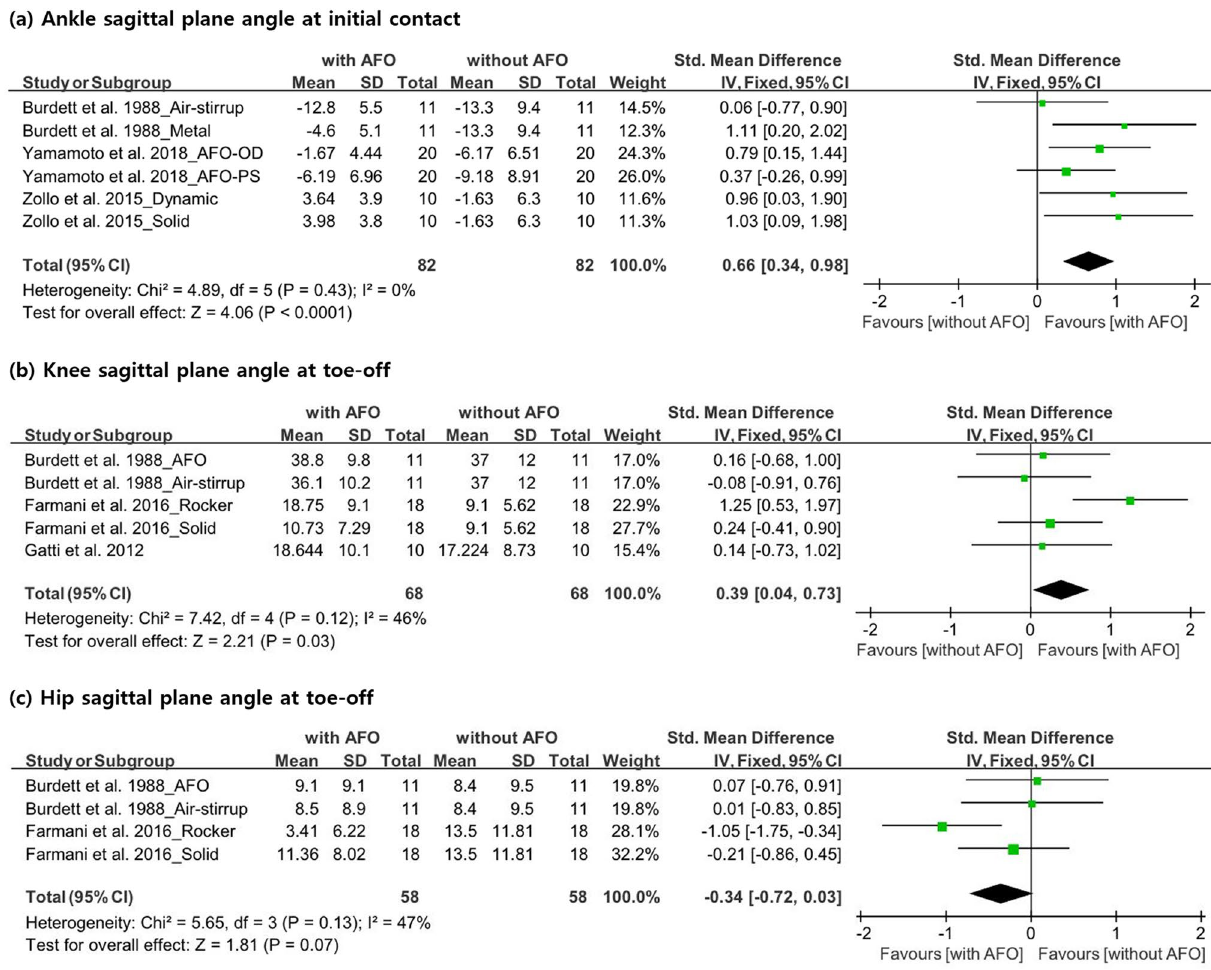
improving knee flexion at toe-off. Farmani et al. 20 used SAFOs and RAFOs and reported that both AFOs were effective. Gatti et al. 21 used one AFO. Our meta-analysis confirmed that the angle of knee flexion increased when wearing an AFO (SMD, 0.39; 95% CI 0.04–0.73; P = 0.03; I 2 , 46%) (Fig. 4). Hip sagittal plane angle at toe‑off (°). The data on hip sagittal plane angle at toe-off were analyzed in two studies that included 29 participants 15,20 . The number of participants was inconsistent between the real data and that in Fig. 4 because both studies used two AFOs. In one of these studies 15 , the hip extension angle was higher with an air-stirrup and metal/plastic AFO than without using an AFO. In contrast, Farmani et al. 20 reported that the hip extension angle was lower when using an SAFO and a RAFO than when not using an AFO. In a meta-analysis, the hip sagittal plane angle at toe-off did not significantly change when wearing an AFO (SMD, − 0.34; 95% CI − 0.72 to 0.03; P = 0.07; I 2 , 47%) (Fig. 4). Publication bias. Publication bias was visually evaluated using a funnel plot showing the relationship between sample size and effect size, and statistically tested using Egger’s test, which tested for symmetry in the funnel plot. The graphic funnel plots of the changes in walking speed, cadence, step length, stride length, stride time, TUG, FAC, body sway, ankle sagittal plane angle at initial contact, and knee and hip sagittal plane angles at toe-off after wearing AFOs were symmetrical (Supplementary 3). Moreover, the P-value of Egger’s test was > 0.05, indicating an insignificant publication bias (walking speed = 0.1749, cadence = 0.4132, step length = 0.8847, stride length = 0.8547, stride time = 0.9386, TUG = 0.3001, FAC = 0.6786, body sway = 0.5562, ankle sagittal plane angle at initial contact = 0.3695, knee sagittal plane angle at toe-off = 0.4908, hip sagittal plane angle at toe-off = 0.4869).